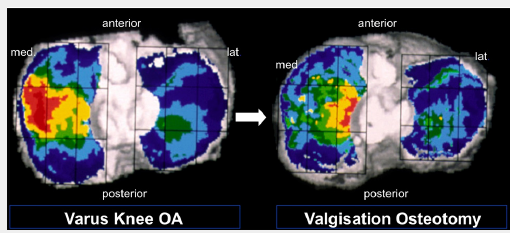
Figure 6 CT-OAM before and 2 years after valgisation osteotomy of the proximal tibia. Areas with high subchondral bone density are coloured in red and yellow (© Madry H, van Dijk CN, Mueller-Gerbl M. The basic science of the subchondral bone. Knee Surg Sports